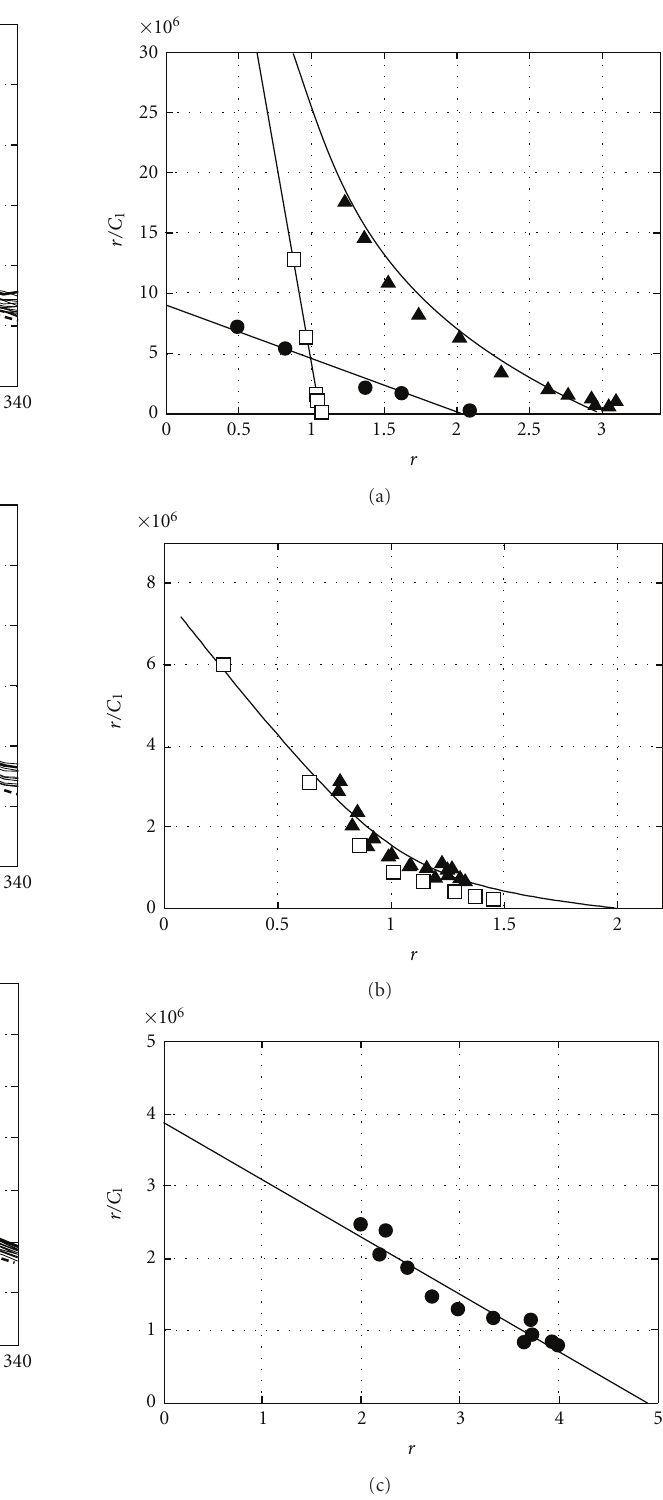
Figure 3: Scatchard plots of AIC:DNA binding. (a) The curve of AIC binding to G-c- Myc (Pu18) registered by UV absorption (triangles) and spectrofluorimetry (squares). The circles represent absorption of nonfluorescent complexes. (b) The curve of AIC binding to G-tel registered by UV absorption (triangles) and spectrofluorimetry (squares). (c) The curve of AIC binding to Pu18 c- Myc duplex registered by UV absorption. The parameters r and ff er, t = 20 ◦ r f were calculated per DNA strand: Hanks’ bu